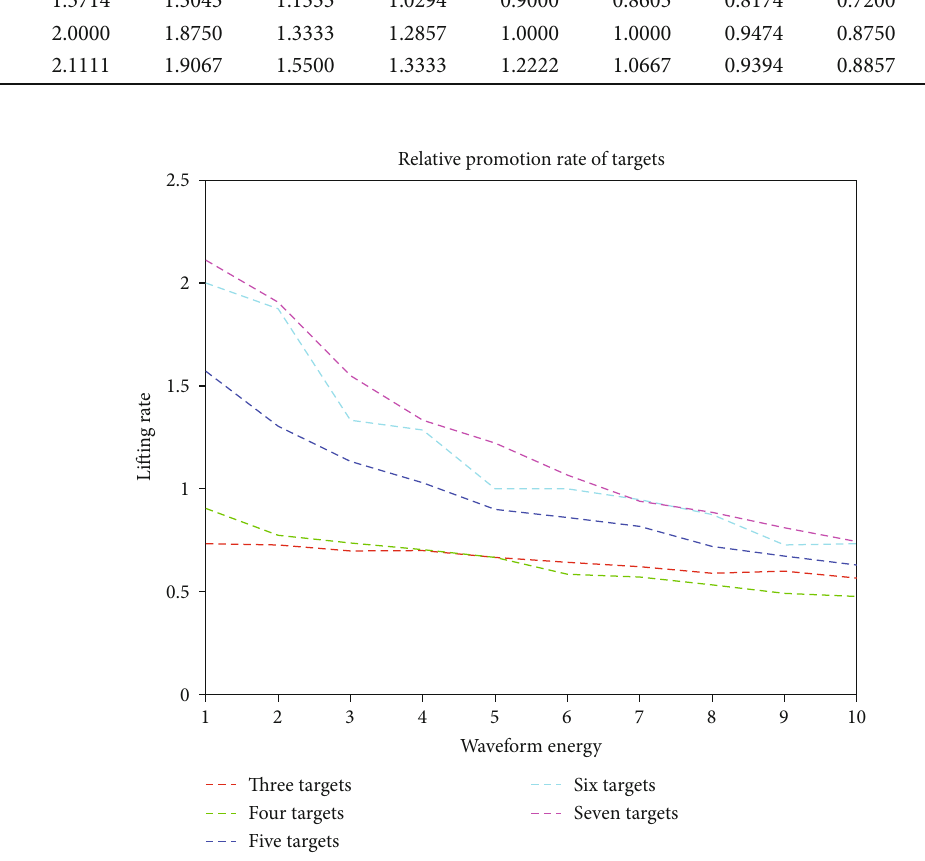
Figure 10: MI lifting rate of robust waveform based on harmonic variance relative to the optimal transmitted waveform in the uncertainty range with di ff erent target numbers.